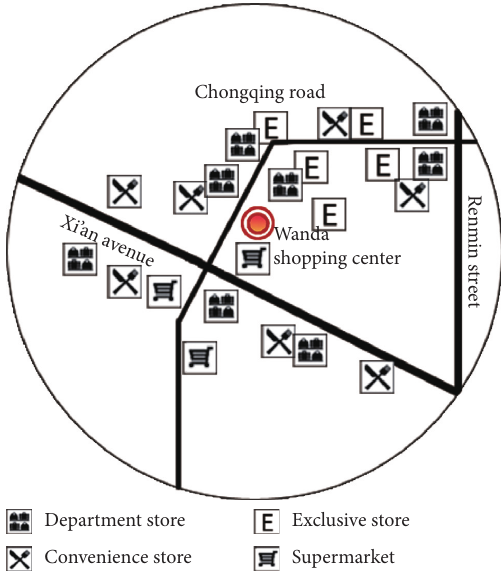
Figure 7: Spatial distribution of retail stores around Wanda shopping center in Chongqing